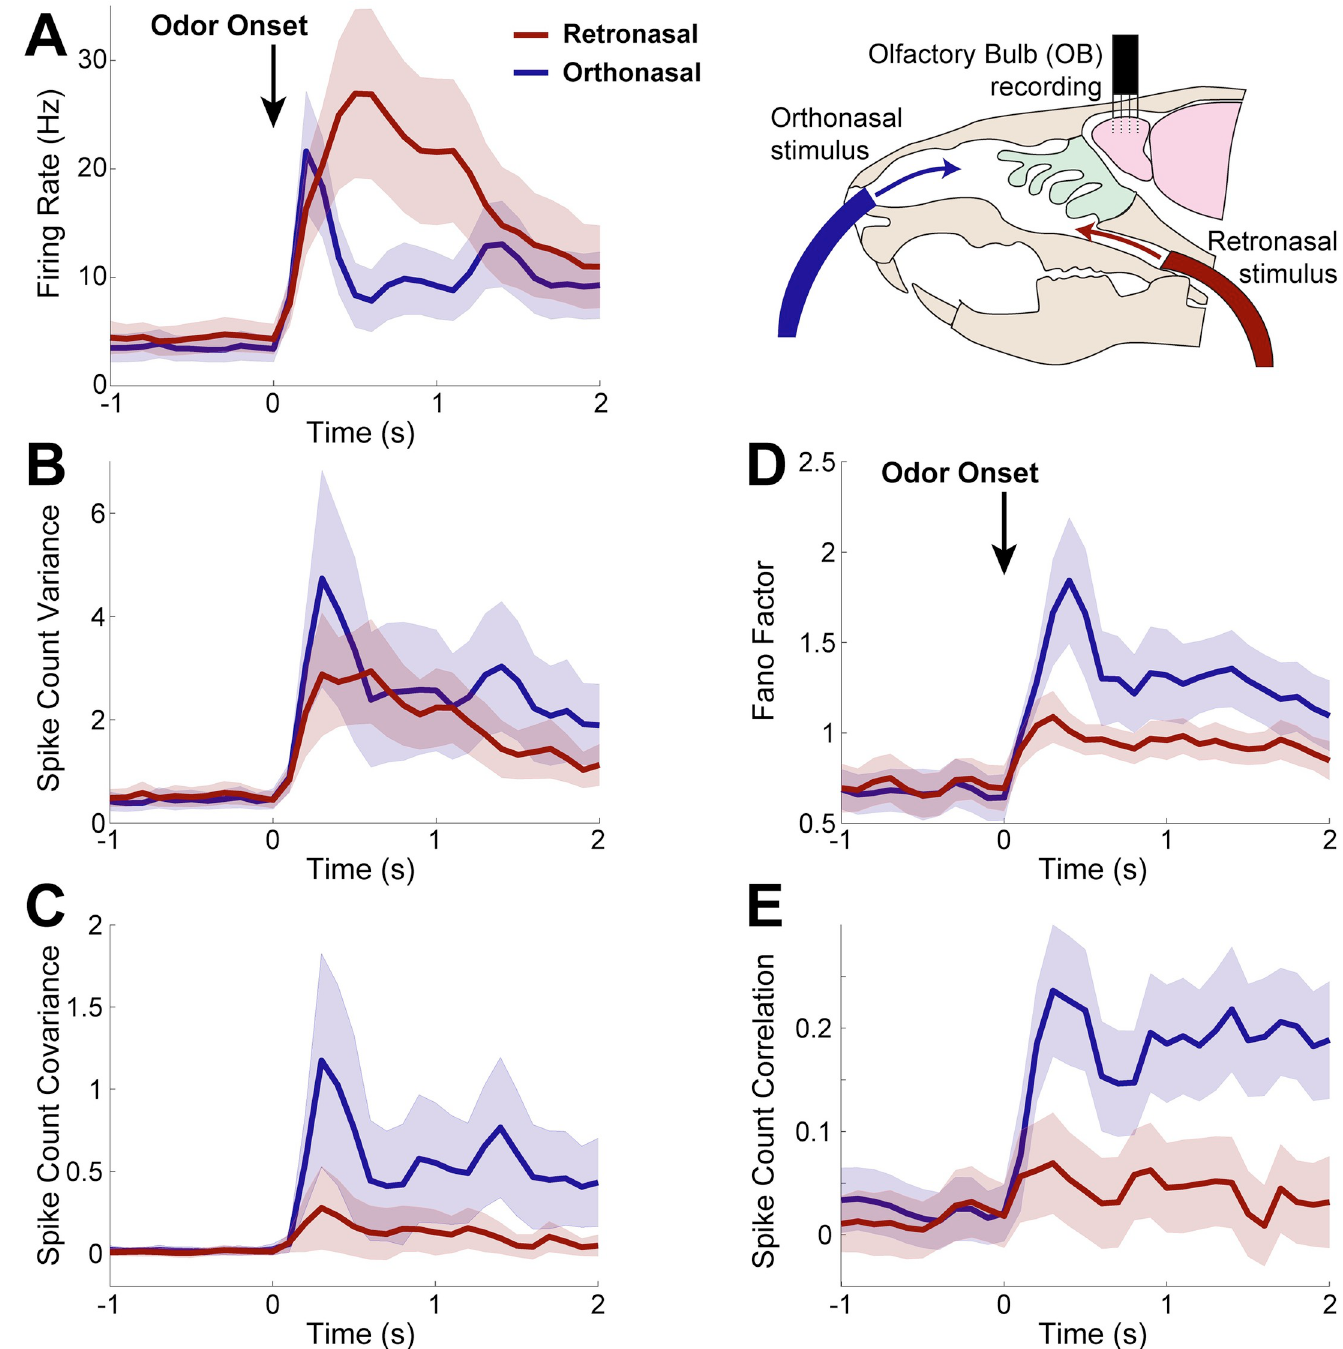
Fig 1. Spike statistics from in vivo multi-electrode array recordings. Population average spike statistics for orthonasal (blue) and retronasal (red) with stimulus onset at time t = 0 s as indicated by black arrow for 1 s duration. A) Firing rate (Hz) is statistically significantly different between ortho and retro for the duration of the evoked period (0.4 � t � 1.1 s). B) Spike count variance has no statistically significant difference between ortho and retro. C) Covariance of spike counts are statistically significant different throughout the evoked state (0 � t � 2) with ortho having larger values. Scaled measures of variability shown for completeness: Fano Factor (D) is the variance divided by mean spike count, and Pearson’s correlation (E) is the covariance divided by the product of the standard deviations; both are also different with ortho versus retro. Spike counts in 100 ms half-overlapping time windows averaging over all 10 trials. Significance: two-sample t-tests (assuming unequal variances) for each time bin to assess differences in population means, p < 0.01, also see S1 and S2 Figs. From 94 total cells and 1435 simultaneously recorded cell pairs; shaded regions show relative population heterogeneity: μ ± 0.2std (standard deviation across the population/pairs after trial-averaging; 0.2 scale for visualization).